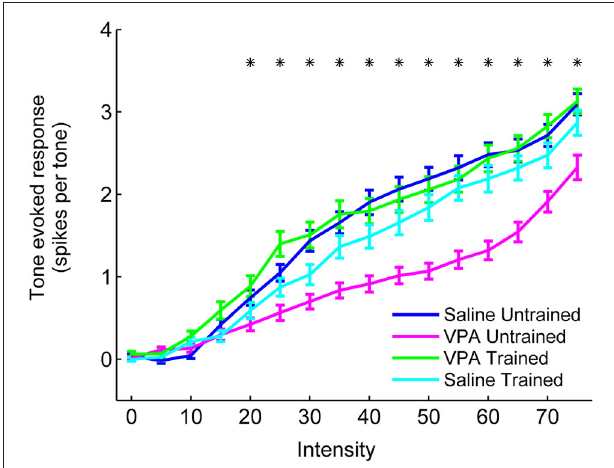
FIGURE 8 | The response strength to tones is enhanced in VPA speech trained rats . VPA untrained rats evoke fewer spikes per tone in AAF compared to saline untrained rats, and this deficit is reversed in VPA speech trained rats. The number of spikes evoked per tone is presented at a range of intensities (0–75 dB). Responses to tones within 1 octave of each site’s characteristic frequency were averaged together. Error bars indicate s.e.m. across recording sites. Asterisks indicate intensities that are statistically significant between VPA untrained rats and VPA speech trained rats ( p < 0.0031, Bonferroni